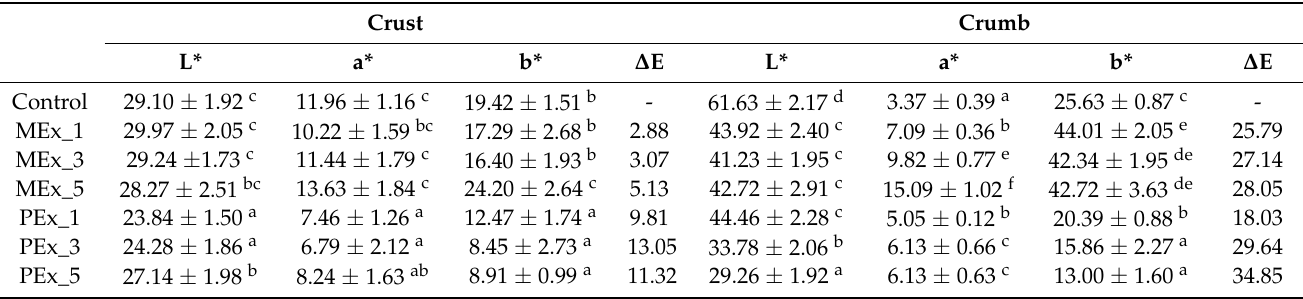
Table 4. Mean ± SD of crust and crumb color coordinates (L*a*b*) and ∆ E of